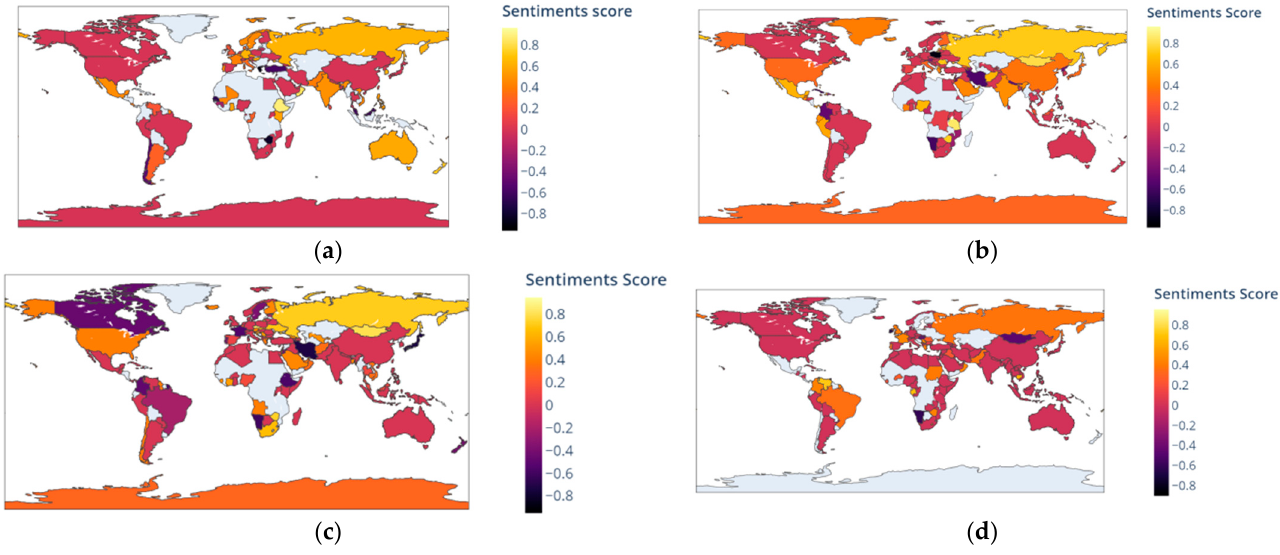
Figure 5. Heat map of four COVID-19 vaccines’ sentiment scores by country: ( a ) heat map of Covaxin; ( b ) heat map of Moderna; ( c ) heat map of Pfizer; ( d ) heat map of Sinopharm.